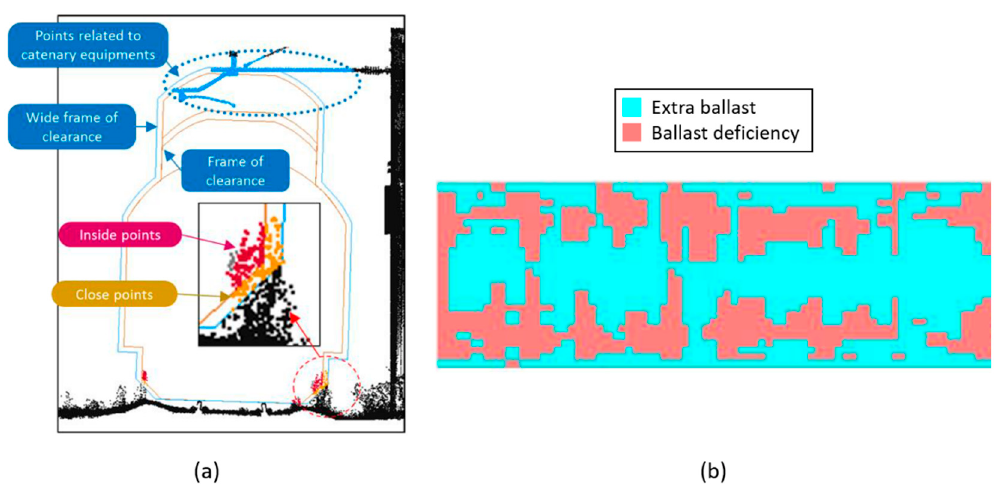
Figure 12. Inspection. ( a ) Niina et al. [170] extracted the rails’ top head to visually inspect the clearance gauge. ( b ) Sadeghi et al. [173] performed a ballast inspection based on a geometry index developed